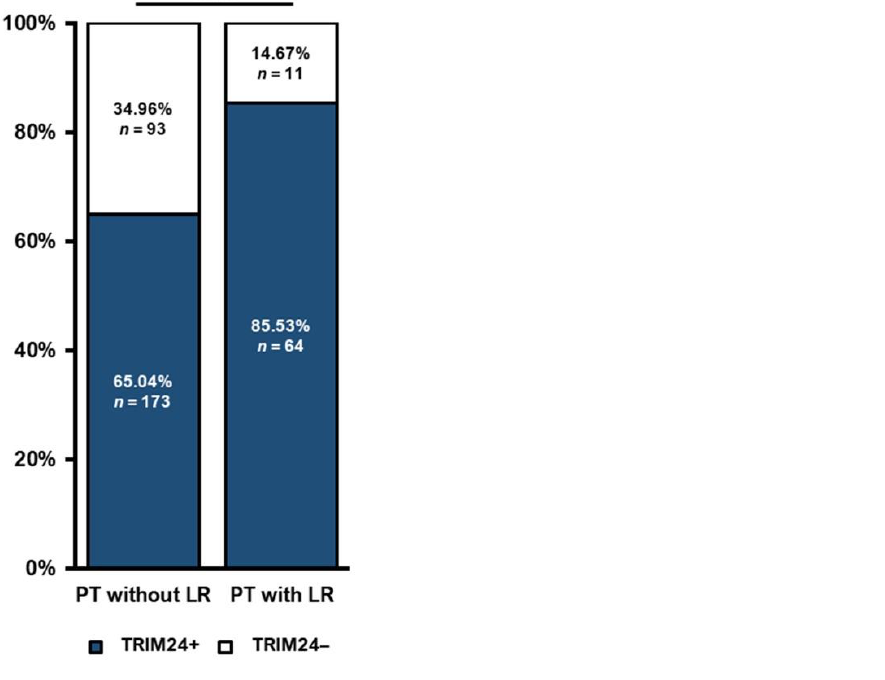
Figure 4. Correlation of TRIM24 expression with the development of a LR and the p16 status in HNSCC. PTs which developed a subsequent LR are significantly more frequent TRIM24+ than PTs without a LR (Chi-square test, p = 0.001). (*** p ≤ 0.001).